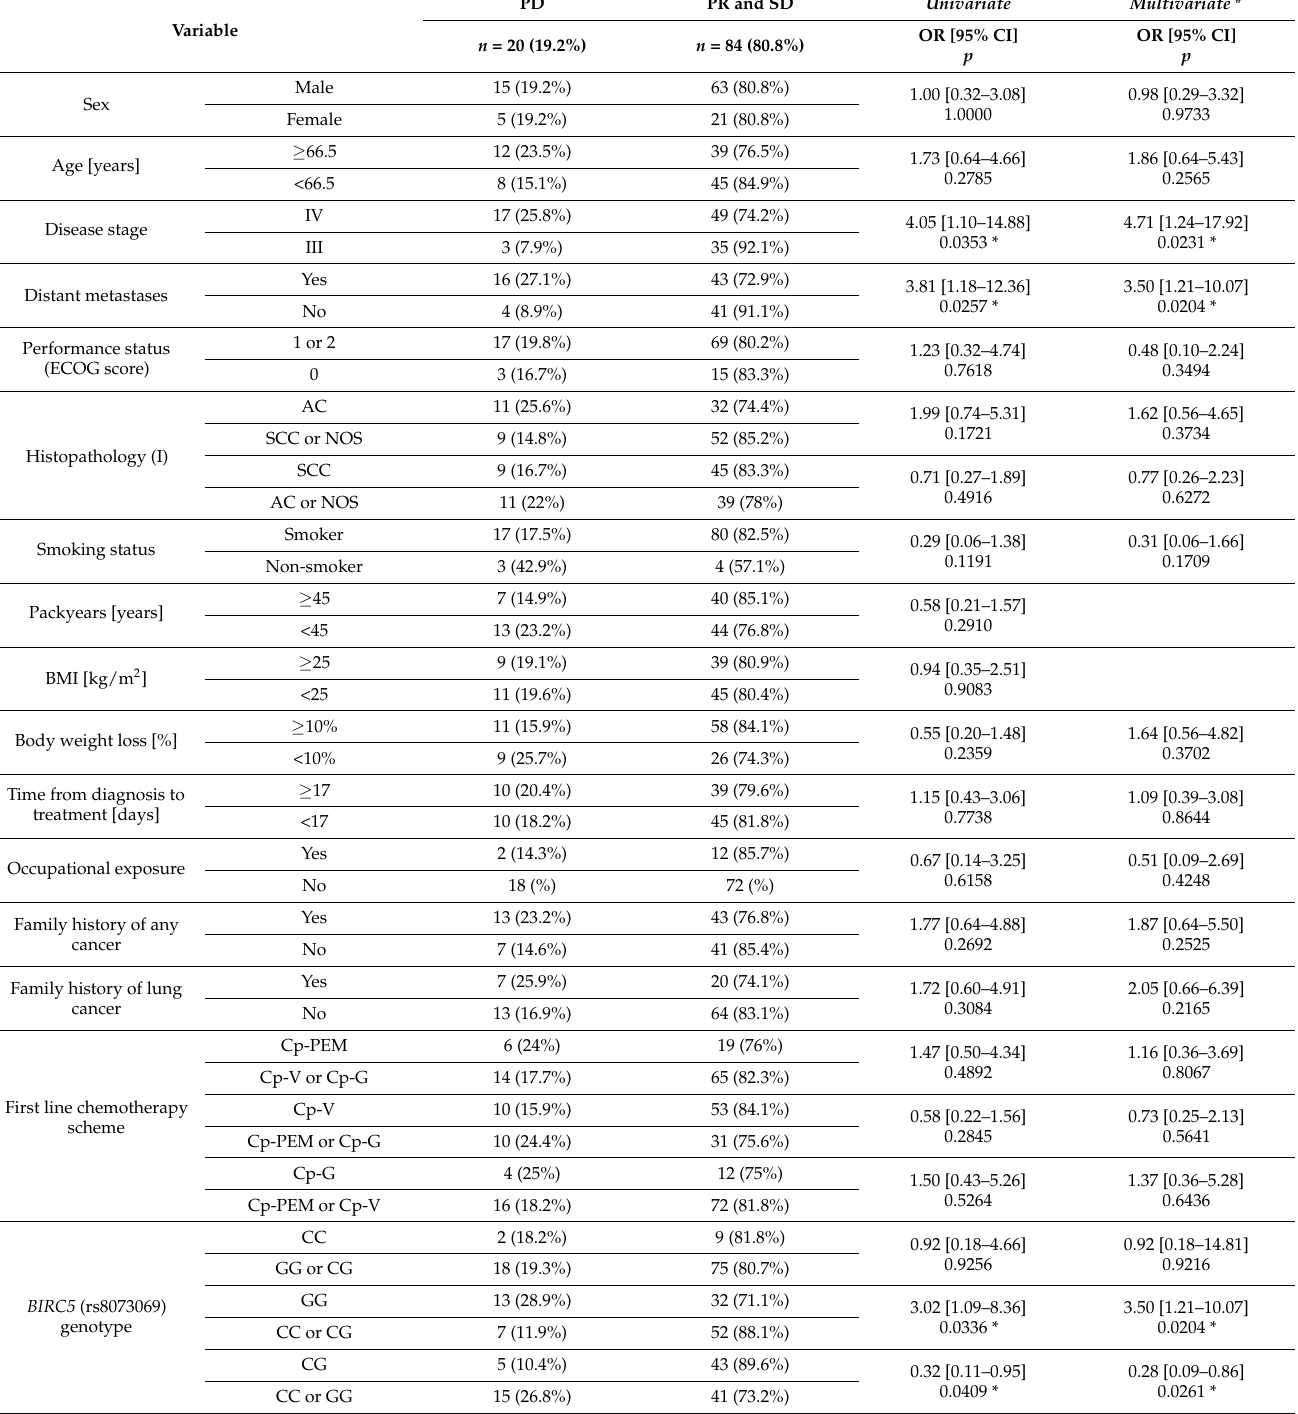
Table 2. Risk of early progression according to demographic, clinical, and genetic